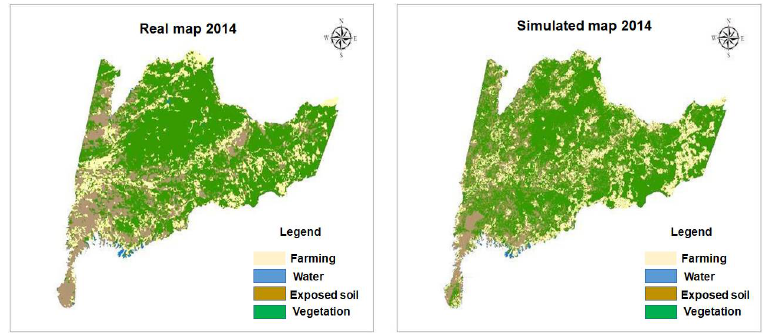
Figure 5. Simulated land use map for the municipality of Floresta, Pernambuco. Table 4. Fuzzy similarity indices obtained from the constant and exponential decay functions for different window sizes in the periods between 2009 and 2014.